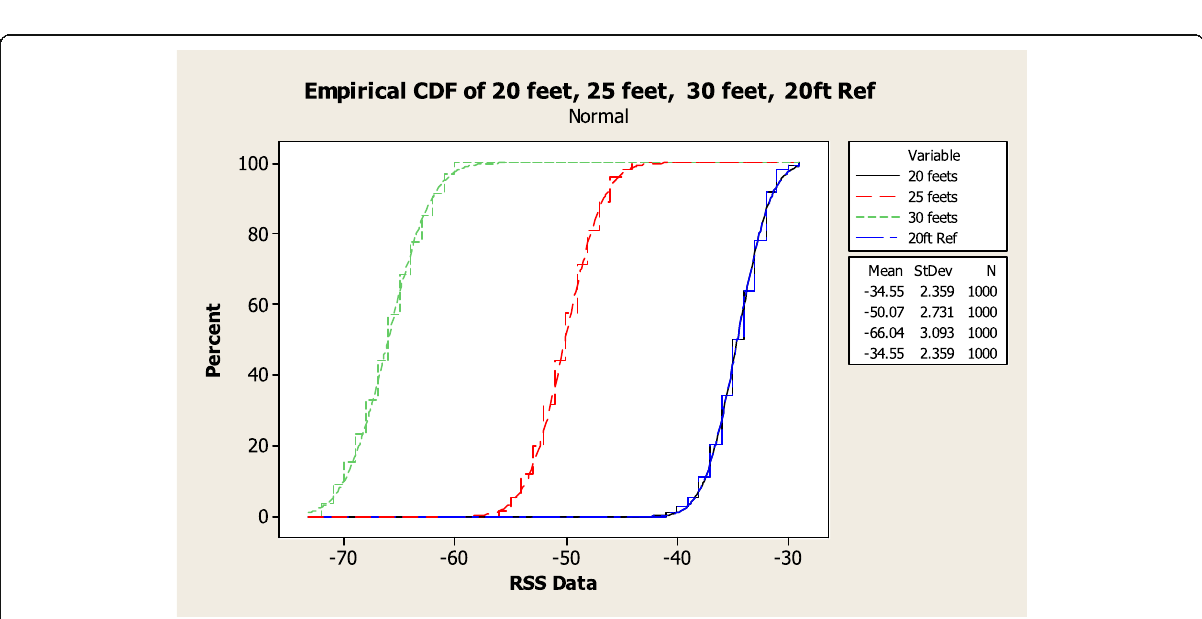
Fig. 3 Empirical CDF of scenario II. Calculates the empirical cumulative distribution function for 20, 25, and 30 ft. The x -axis represents the RSS data, while the y -axis represents the percentage value of each graph. It also shows the mean and standard deviation values of the three instances taken in the scenario